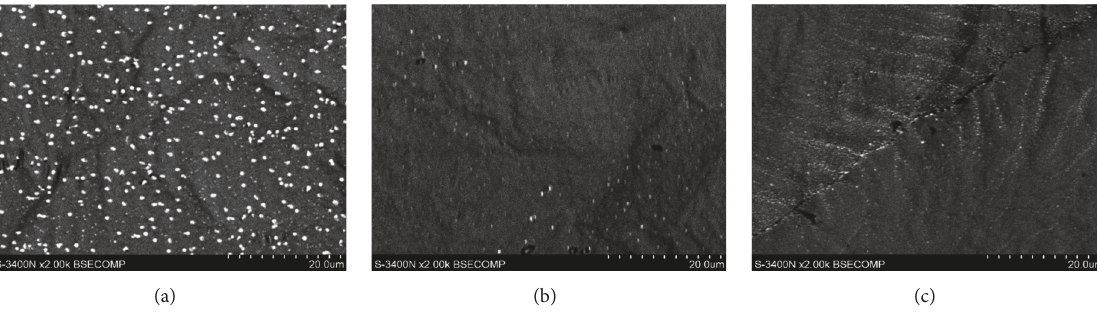
Figure 3: SEM micrographs of water-cooled sample surfaces: (a) Pb 1.2, (b) Pb 0.8, and (c) Pb 0.4.